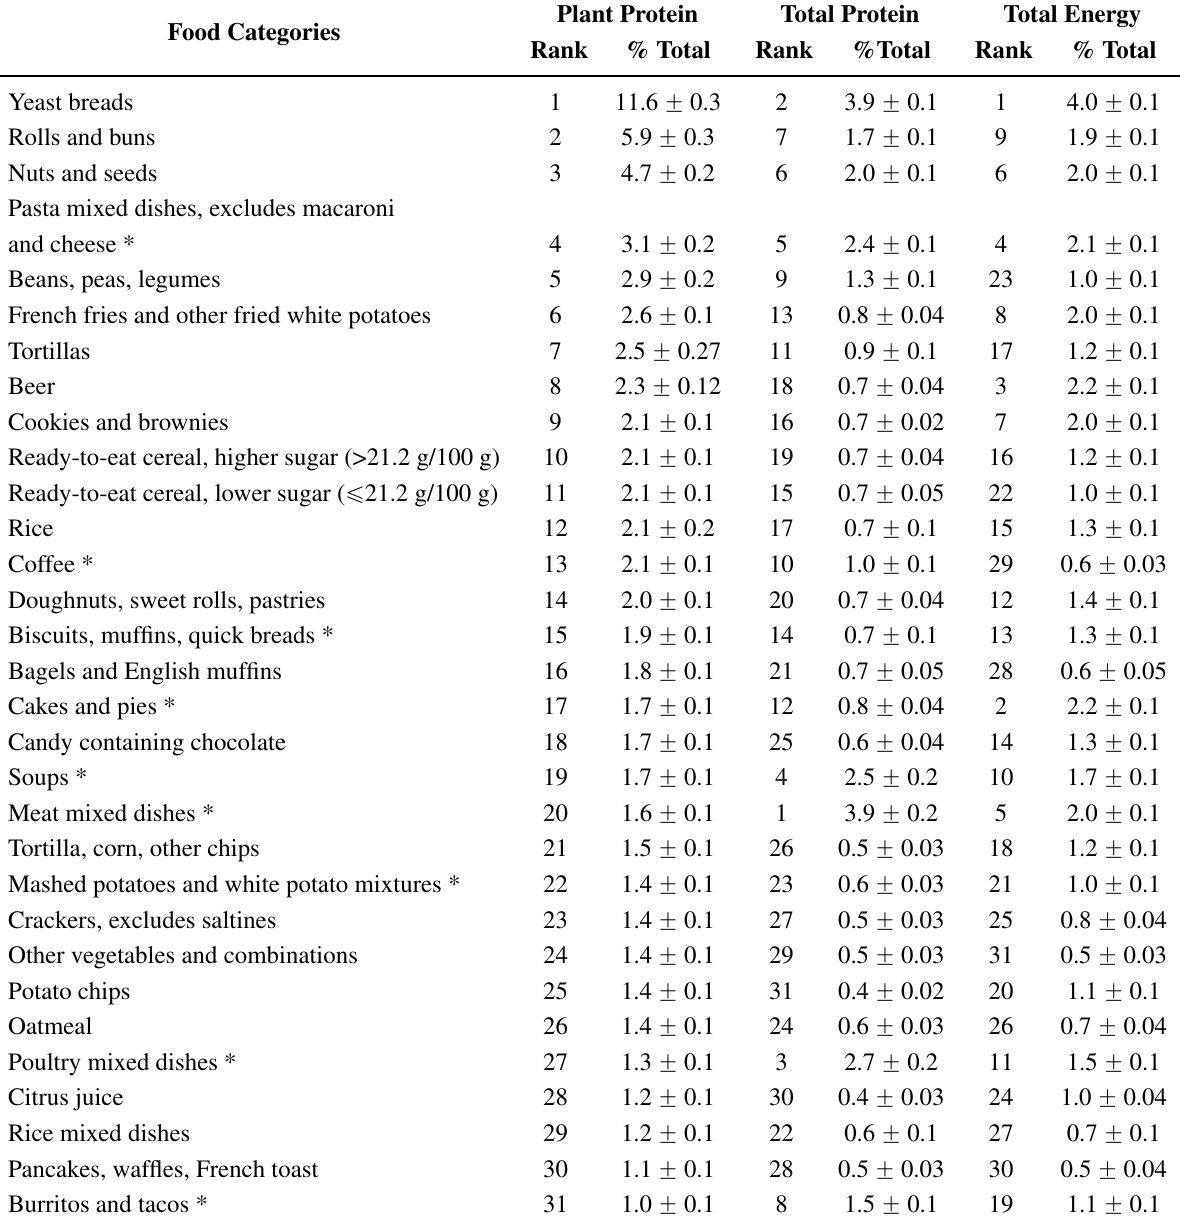
Table 4. Food sources of plant protein (providing at least 1% dairy protein) and energy among US adults age 19 years and older. Data from NHANES